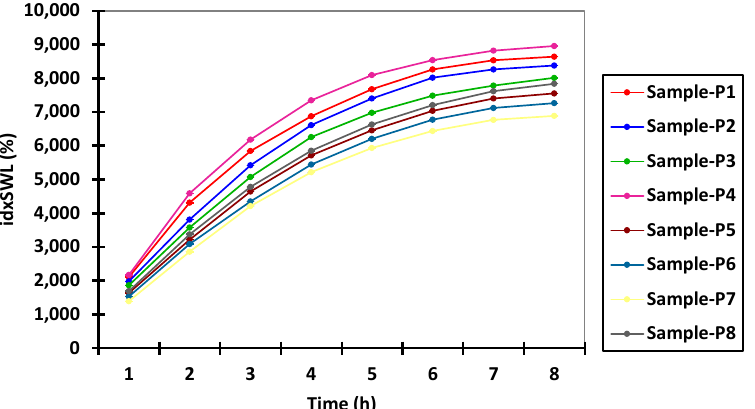
Figure 4. Interval plots of the swelling index (idxSWL (%)) of the microspheres for Sample * Time interaction factor levels.